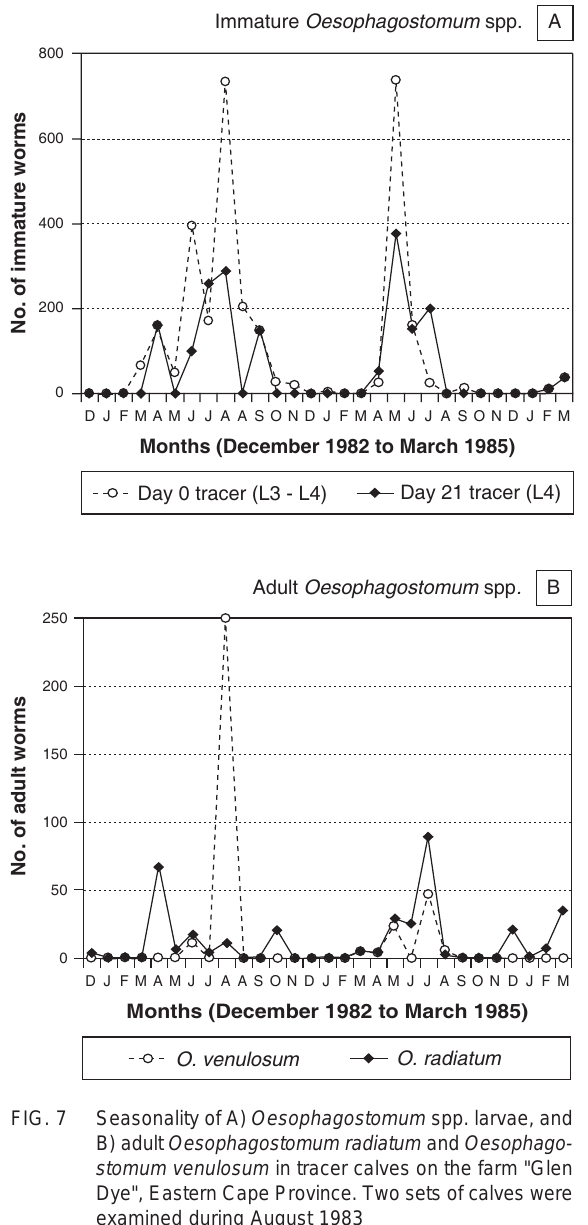
FIG. 7 Seasonality of A) Oesophagostomum spp. larvae, and B) adult Oesophagostomum radiatum and Oesophago- stomum venulosum in tracer calves on the farm "Glen Dye", Eastern Cape Province. Two sets of calves were examined during August